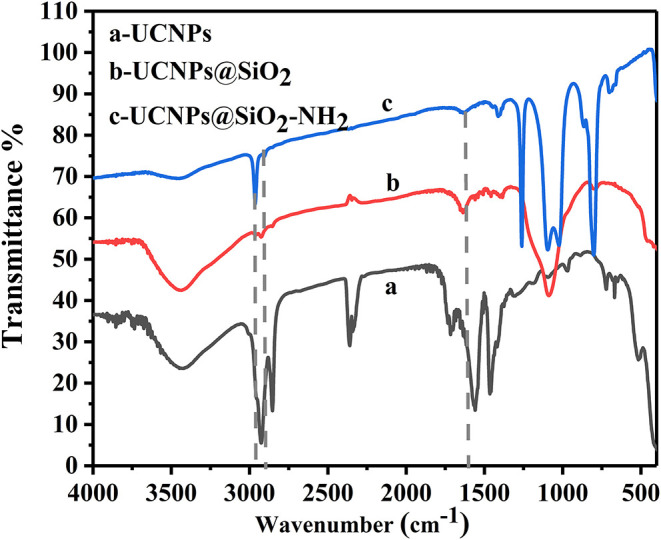
The FT-IR spectra of UCNPs before and after SiO2 and NH2 modification.